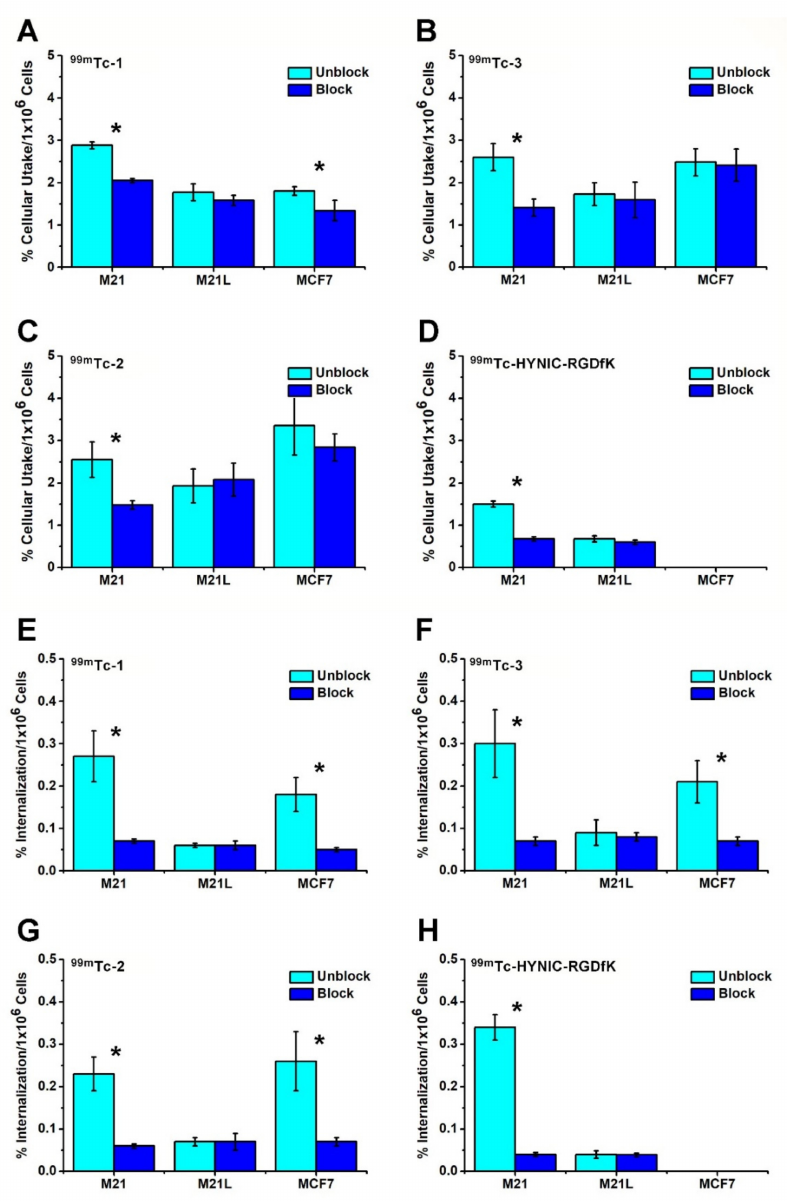
Figure 4. In vitro 99m Tc complexes cellular uptake ( A – D ) and internalization ( E – H ) in integrin- positive and integrin-negative tumor cell lines. * Statistically significant difference between block and unblock cells ( p value ≤